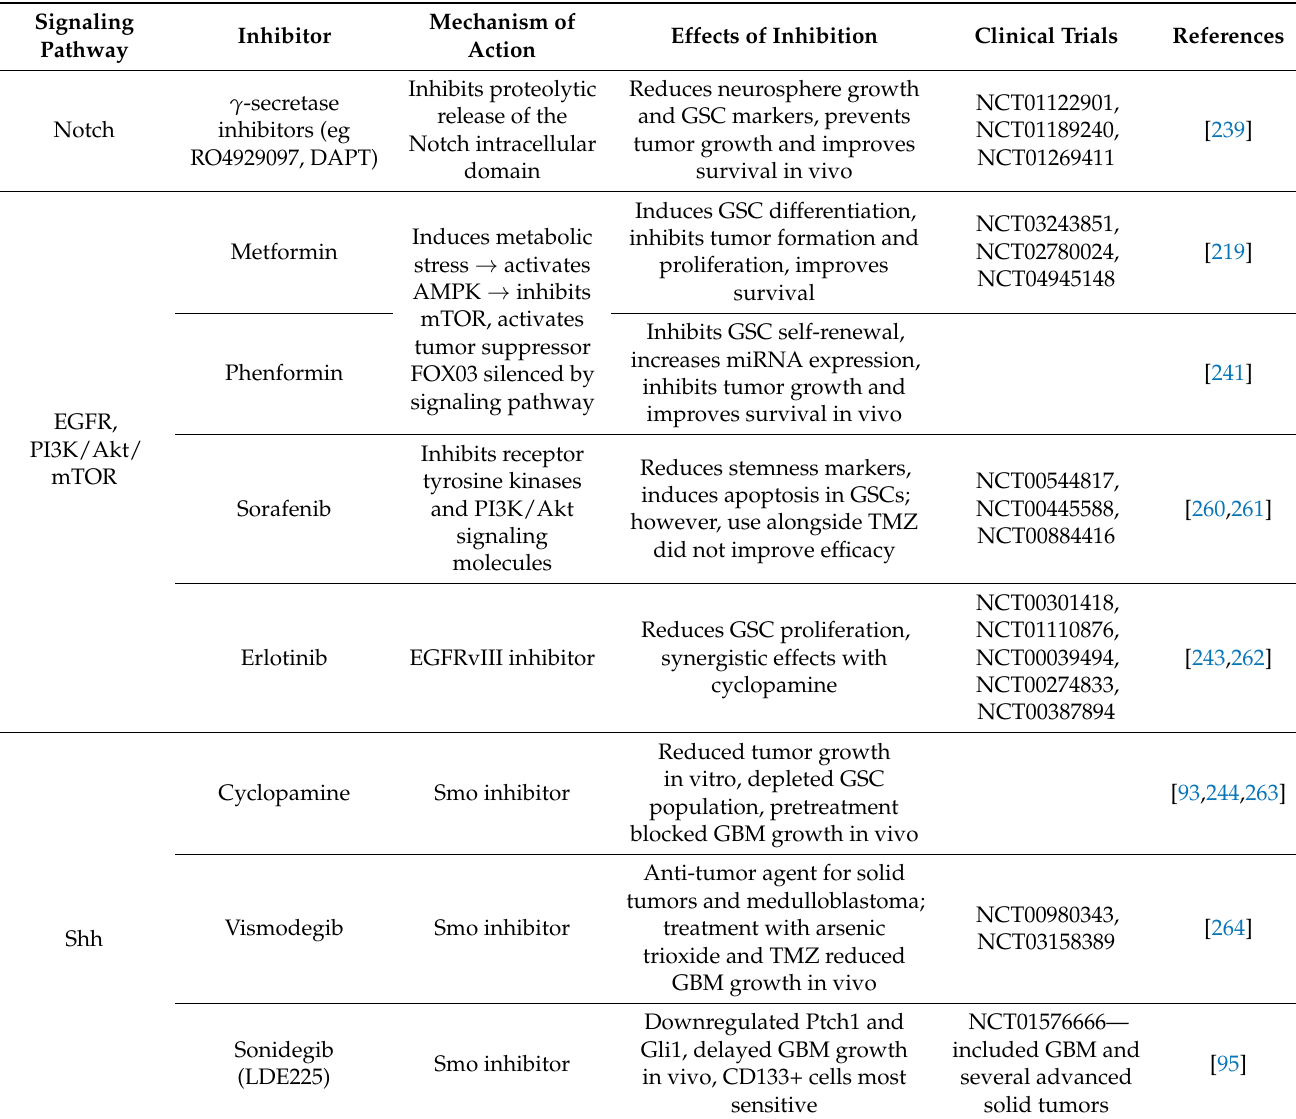
Table 1. Key signaling pathways identified in GSCs and representative